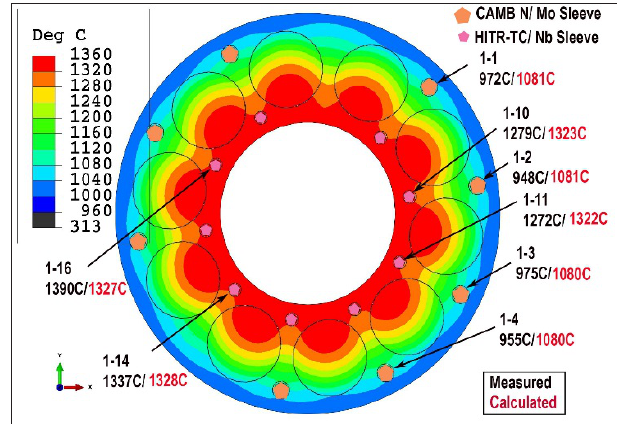
Fig. 5. Measured vs calculated temperatures for capsule 1 early in first irradiation cycle.